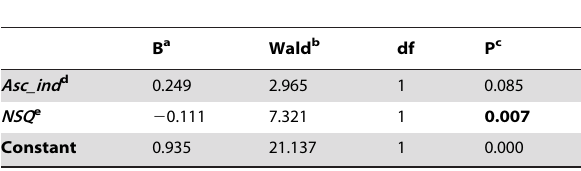
Table 3. Results for SNP detection variables for predicting SNP assay polymorphism following a backward